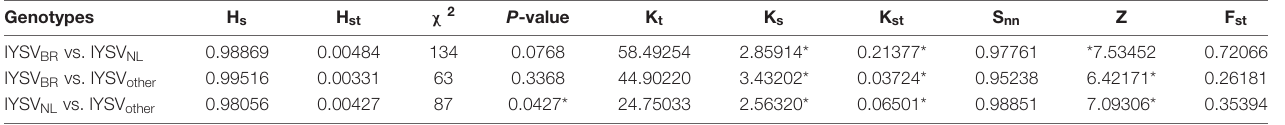
TABLE 5 | Gene flow and genetic differentiation of Iris yellow spot orthotospovirus genotypes. Genotypes H s H st χ 2 P -value